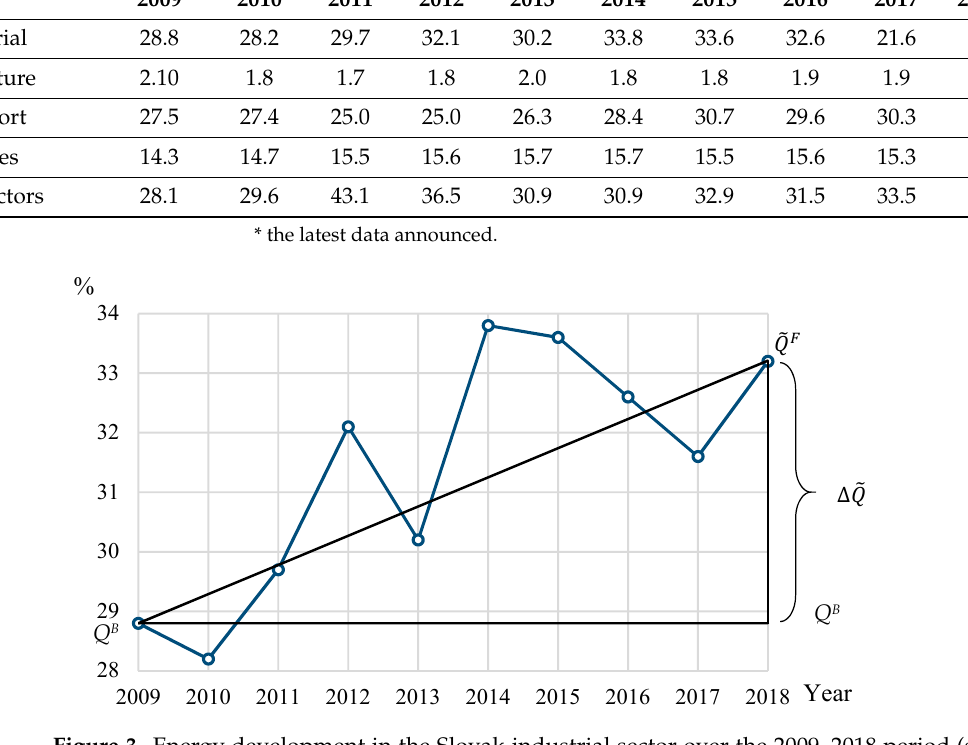
Figure 3. Energy development in the Slovak industrial sector over the 2009 – 2018 period (source: compiled by the authors).